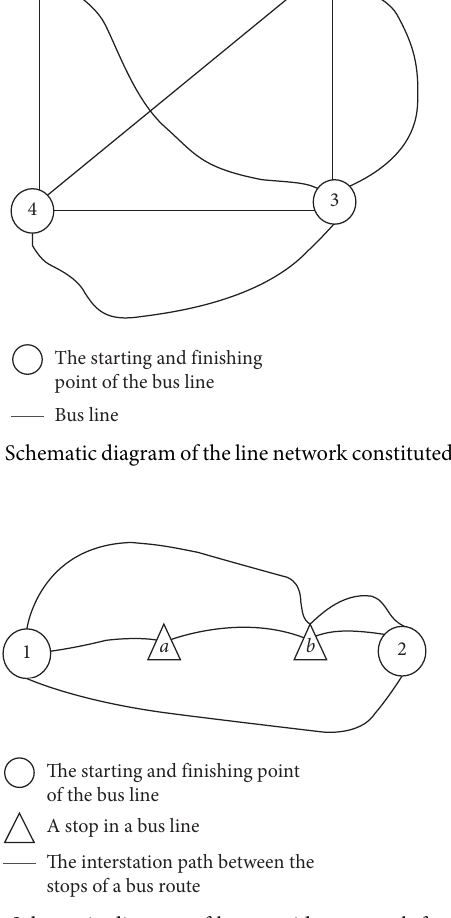
Figure 2: Schematic diagram of bus corridor network formed by routes between bus stations.